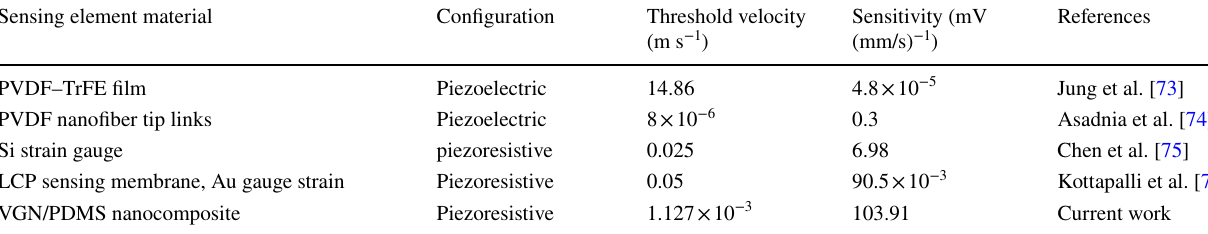
Table 1 Sensor performance comparison in terms of threshold velocity and sensitivity Sensing element